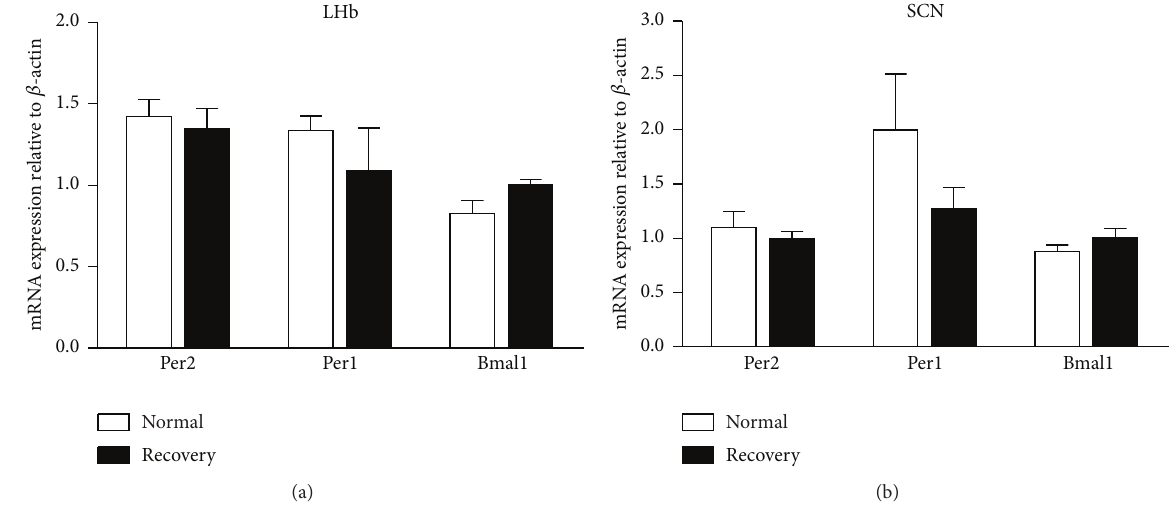
Figure 4: qPCR analysis of Per1, Per2, and Bmal1 levels in the LHb following 2 hours of recovery after sleep deprivation. Data was presented as mean ± SEM ( 𝑛 = 8 /each